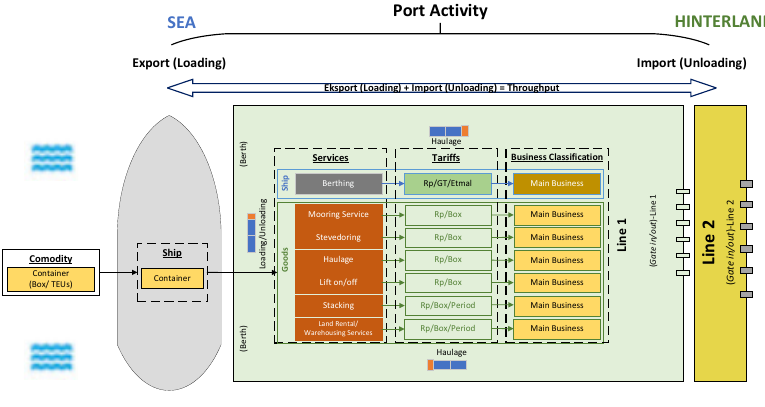
Figure 2: Container Terminal Business